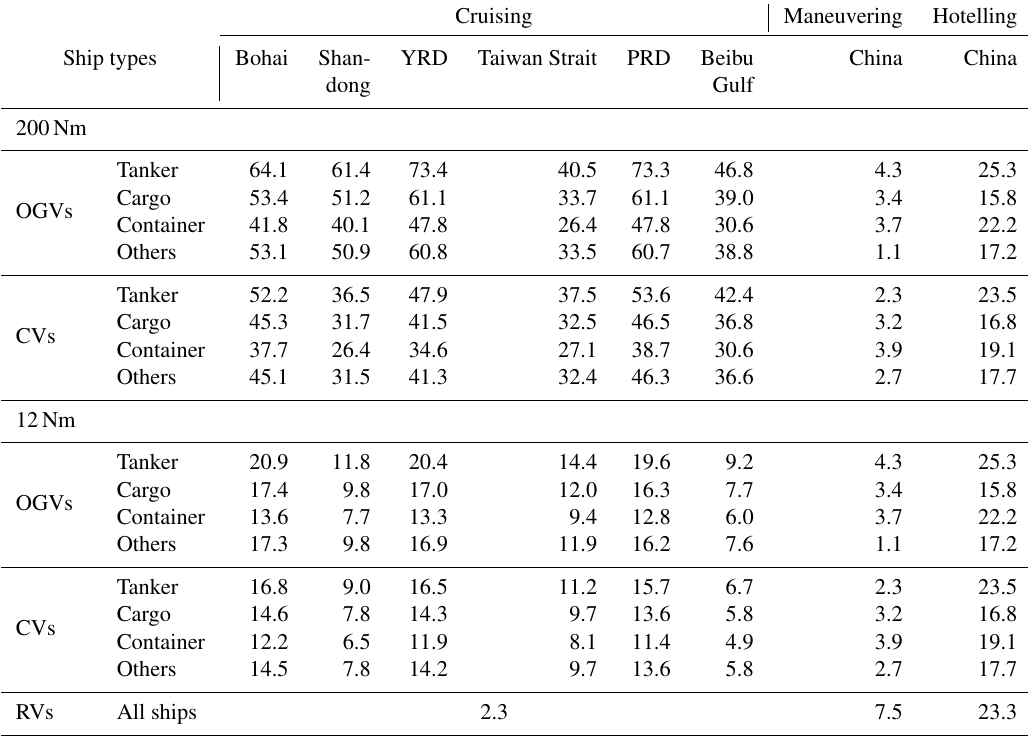
Table 1. Time in mode for different ship types within 12 and 200Nm of the coast (unit: hvoyage − 1 ). Cruising Maneuvering